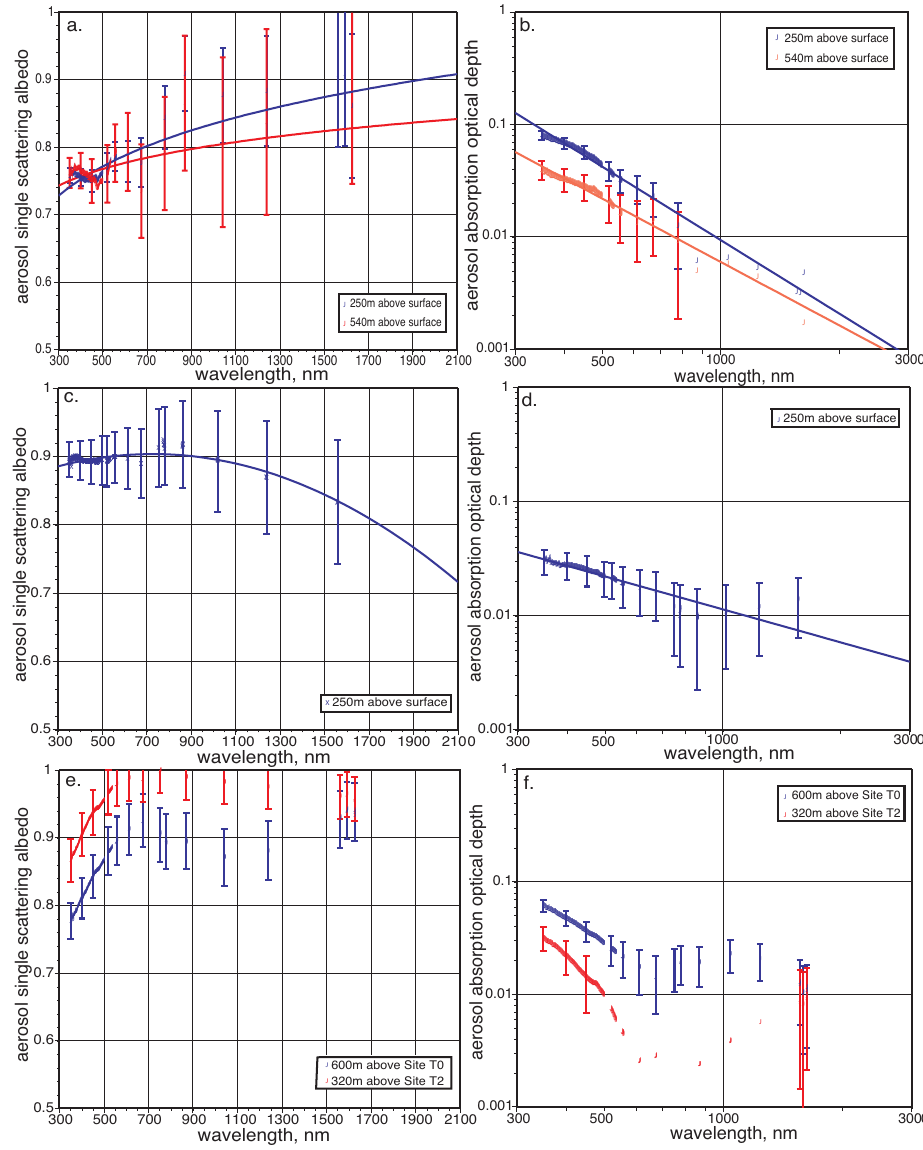
Fig. 6. (a) and (b) : Aerosol single scattering albedo and absorption optical depth for 6 March 2006. (c) and (d) : Aerosol single scattering albedo and absorption optical depth for 15 March 2006. (e) and (f) : Aerosol single scattering albedo and absorption optical depth for 19 March